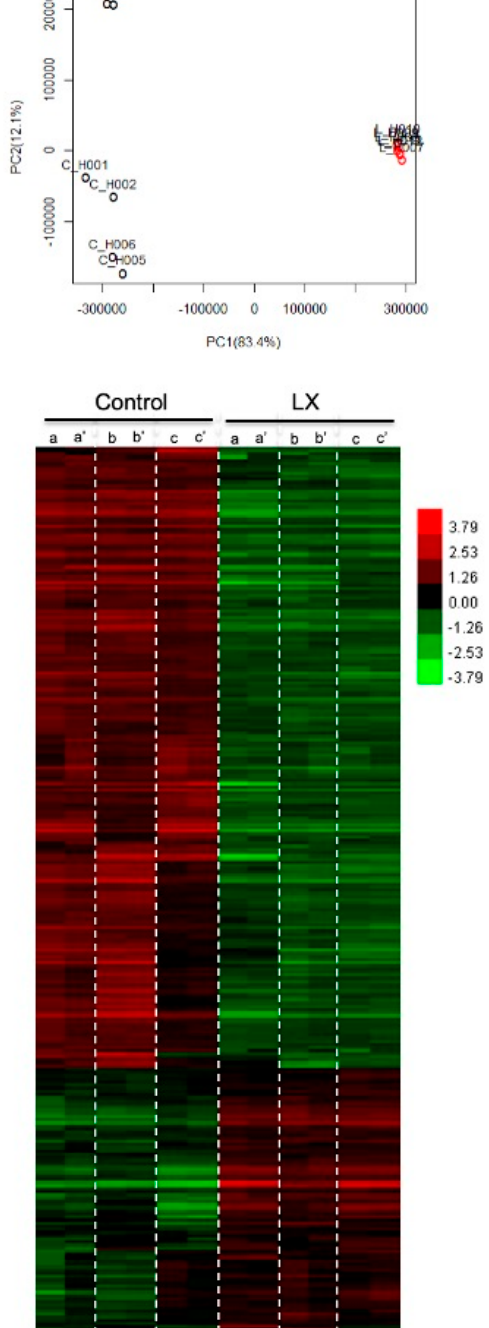
Figure 10. Dystrophic skeletal muscle gene expression profile is significantly altered by LX2931 treatment. ( A ) Principal component analysis of microarray comparison of gene expression in tibialis anterior muscles of three control and three LX2931-treated mdx mice run in duplicates. The variable of the first three principal components (PC1, PC2 and PC3) were 83.4, 12.1 and 2.2%, respectively. Note the uniformity of the LX2931-treated expression pattern. ( B ) Heat map of microarray results from 285 genes identified as differentially expressed between control and LX2931-treated (LX) mdx mice, with high expression shown in red and low expression shown in green. The majority of differentially expressed genes in the treatment group were downregulated compared to the control